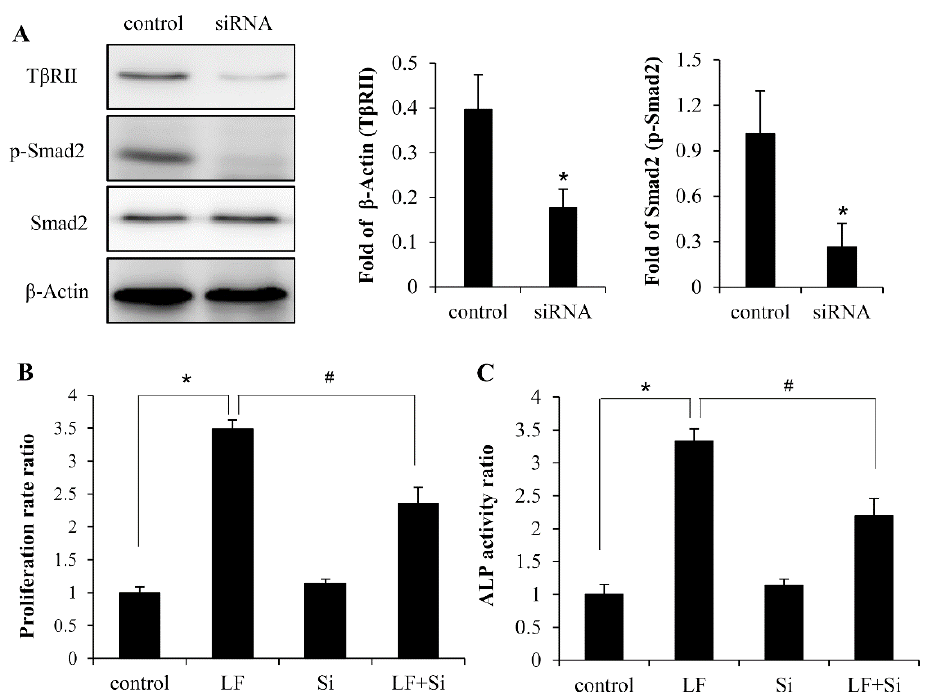
Figure 4. Inhibition of TβRII expression attenuated LF-induced osteogenic activity in C3H10T1/2 cells. The knockdown effect of TβRII siRNA on TβRII expression and the phosphorylation level of LF-induced p-Smad2 was determined ( A ). After pretreating cells with siRNA, LF (100 μg/mL)-induced proliferation ( B ) and differentiation ( C ) were detected. Values are means ± SDs, n = 3 (means of 5 replicates). * p < 0.05 compared with the control group; # p <0.05 compared with the LF + Si–treated group.